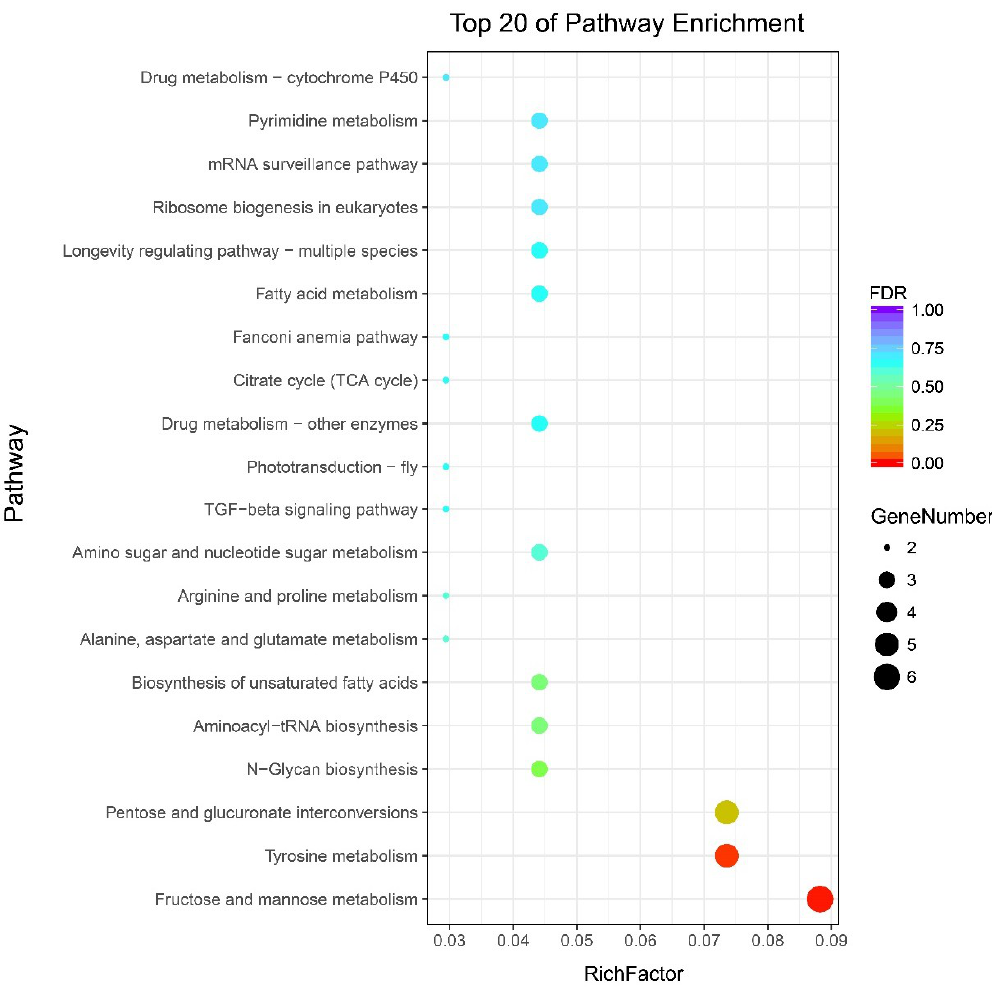
Figure 7. Scatterplot of enriched KEGG analyses for DEGs. The rich factor indicates the ratio of DEG numbers annotated in this pathway group to total gene numbers annotated in this pathway group. The larger the rich factor, the larger degree of pathway enrichment. The FDR ≤ 0.05 means significant pathway enrichment.